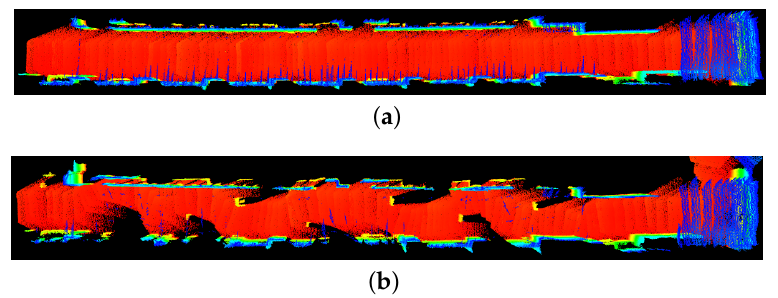
Figure 14. Top view of the 3D point cloud map in Experiment 2. ( a ) Initial map without obstacles; ( b ) Map with obstacles.